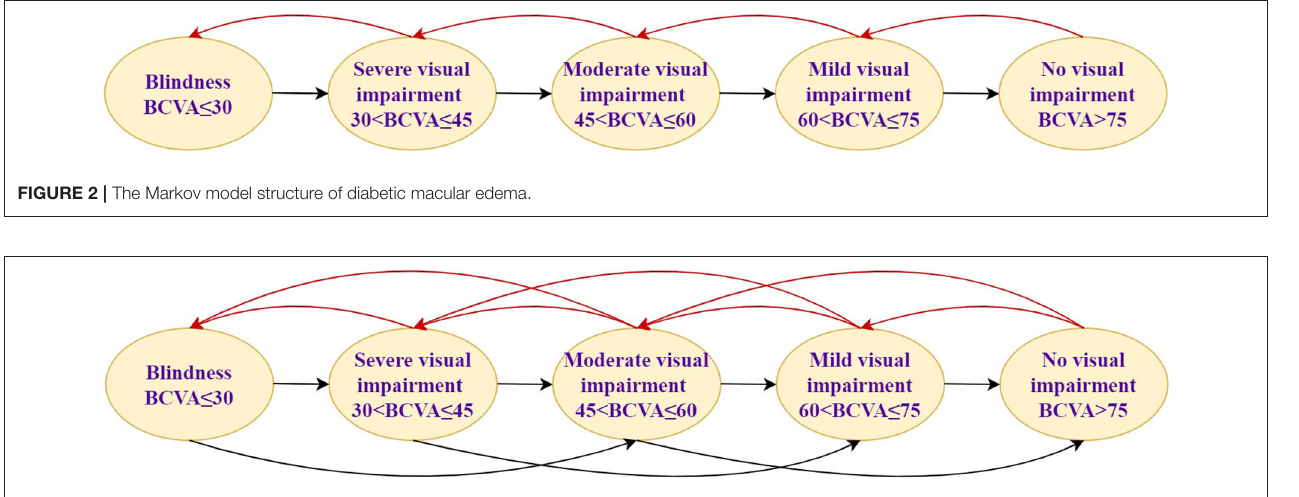
FIGURE 3 | The Markov model structure of pathological myopia.